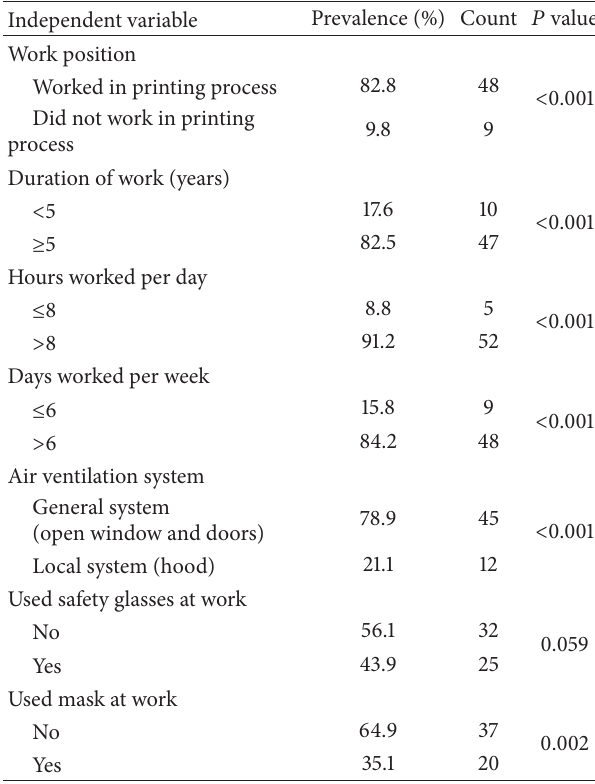
Table 6: Prevalence of allergic skin reaction in the preceding 6 months, by independent variables: work position, duration of work, hours worked per day, days worked per week, air ventilation system, and use of